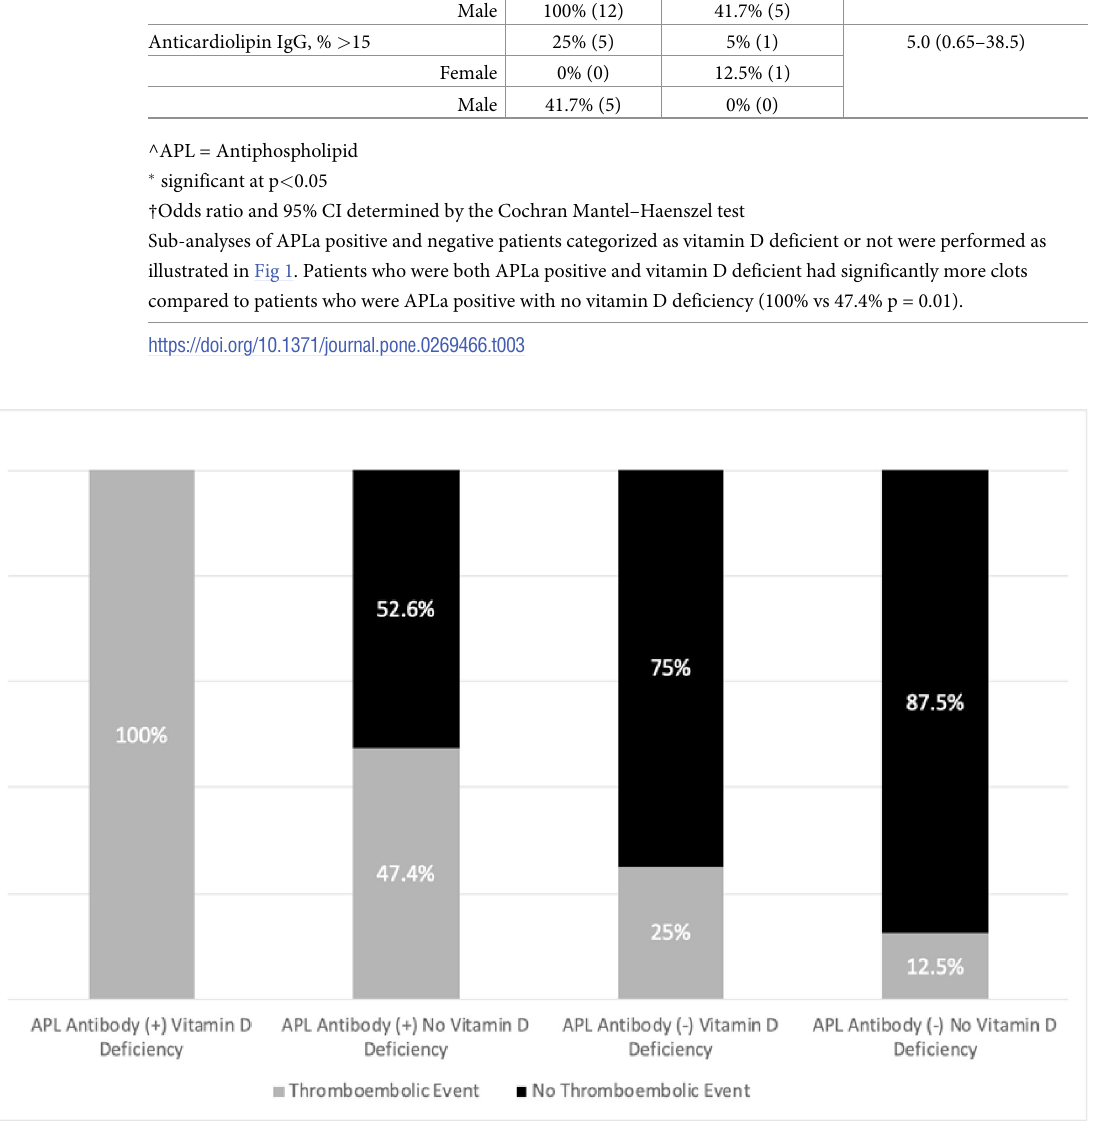
Fig 1. Assessment of antiphospholipid antibodies and vitamin D combinations.